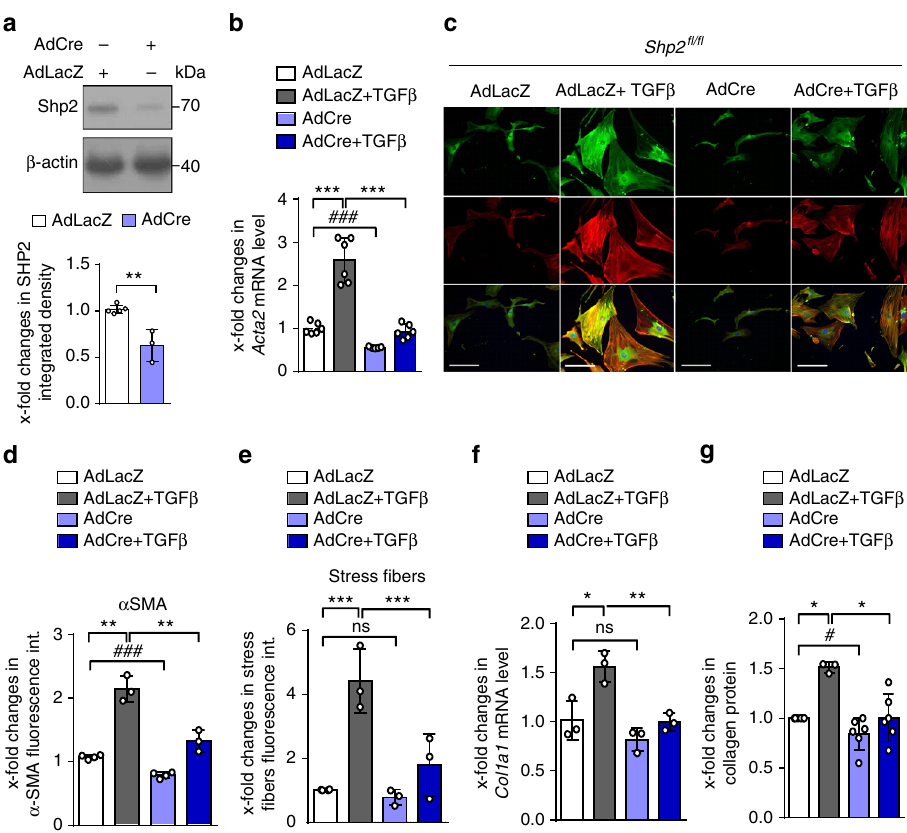
Fig. 3 Shp2 regulates TGF β induced fi broblast activation. a Western blot for ef fi ciency of Cre-mediated (80 IFUs/cell) knockout of Shp2 in murine Shp2 fl / fl fi broblasts ( n ≥ 3 per each group). b Shp2 knockout decreased mRNA levels of Acta2 ( n = 6). c – e Shp2 knockout decreased α -SMA and stress fi ber staining. Representative images are shown at 200-fold magni fi cation ( c ). Horizontal scale bar, 500 μ m. Quanti fi cation of α -SMA staining intensity ( d ) and stress fi ber staining intensity ( e ) ( n ≥ 3 different lines). f , g Col1a1 mRNA ( f ) and collagen protein release ( g ) induced by TGF β (10 ng/ml for 24 h) ( n ≥ 3 different lines). Results shown are representative of three independent experiments. All data are presented as median± s.e.m. The p values are expressed as follows: 0.05 > p > 0.01* or # ; 0.01 > p > 0.001**; p < 0.001*** or ### ; ns: not signi fi cant. Signi fi cance was determined by Mann – Whitney test. AdCre: